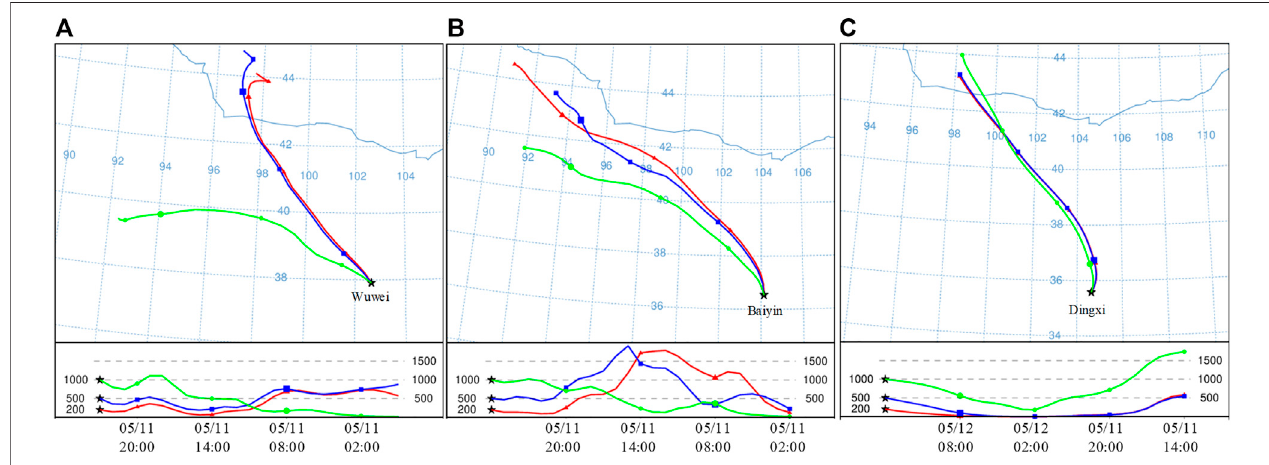
FIGURE 8 | 24-h HYSPLIT backward trajectories: (A) Wuwei at 23:00 on 11 May; (B) Baiyin at 02:00 on 12 May; and (C) Dingxi at 14:00 on 12 May.